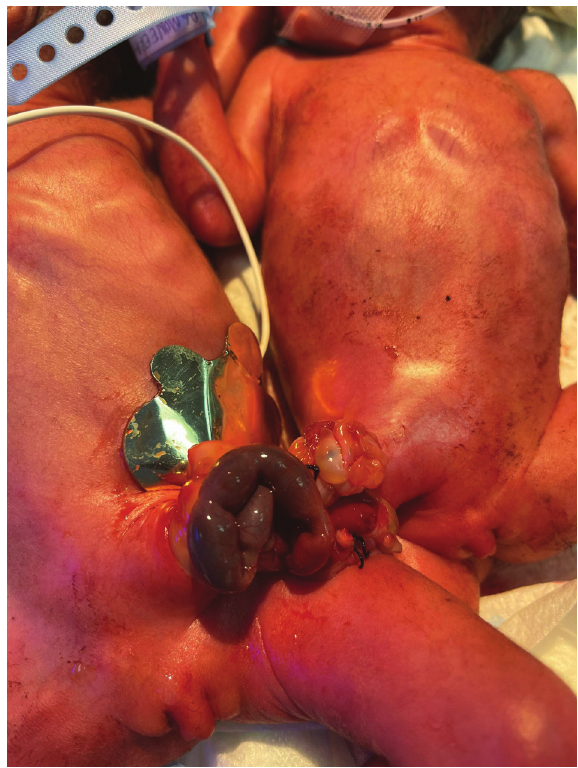
Fig. 1 The conjoined twins upon initial assessment following birth. Note: the conjoined segment with a dusky segment of small bowel.